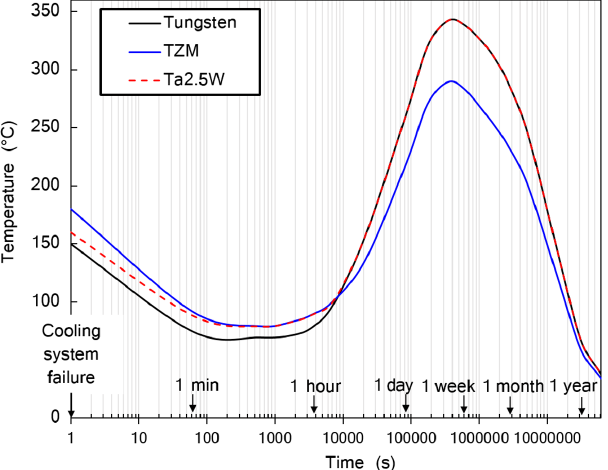
FIG. 13. Evolution of the maximum temperature in the different target materials after a cooling system failure due to the decay heat generated inside the target (logarithmic